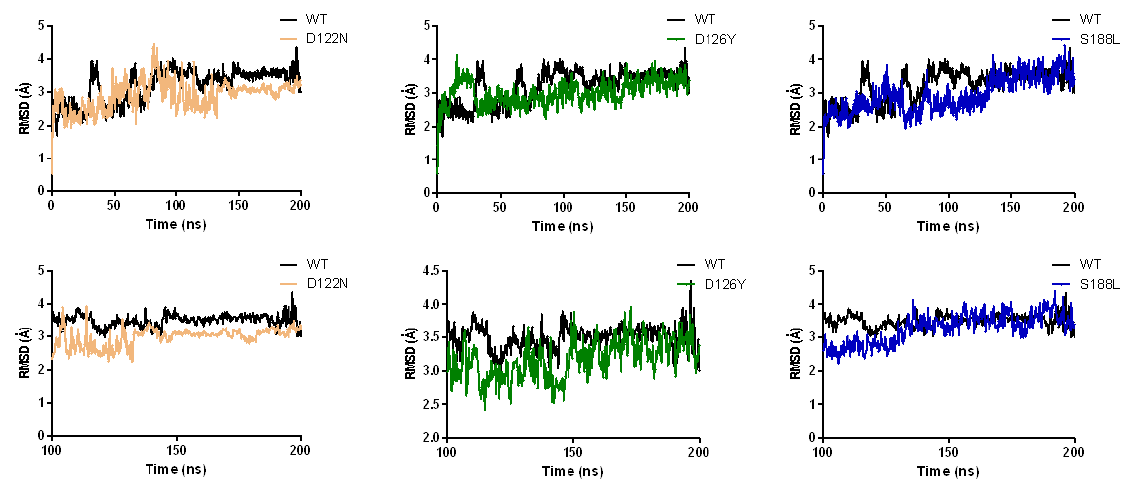
Figure 6. Analysis of the molecular dynamic trajectories of 200 ns by root mean square deviation (RMSD) plots of wild-type and mutant MC4R complex structures. The RMSD plots show the deviation of mutants compared to the wild type during the simulation.